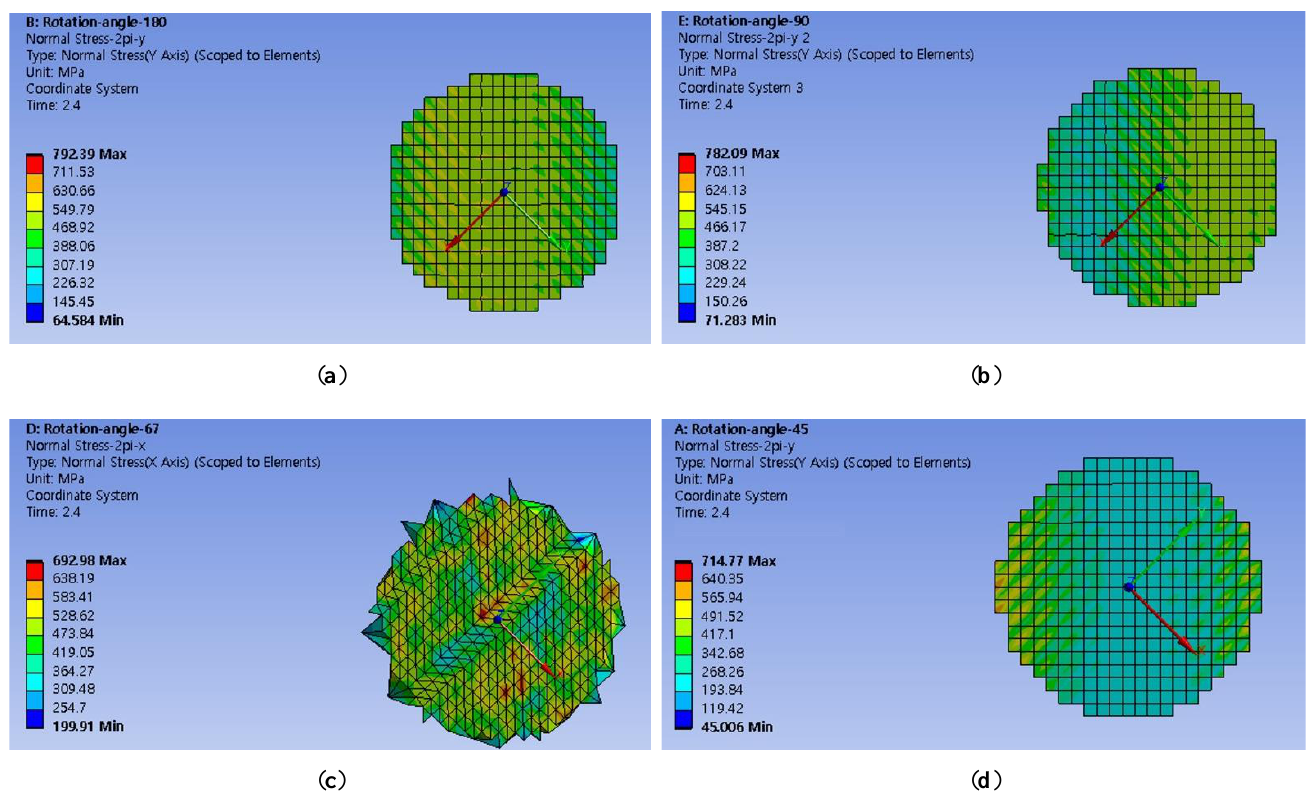
Figure 10. Residual stress results of XRD measurement area. ( a ) Rotation angle = 180°, ( b ) Rotation angle = 90°, ( c ) Rotation angle = 67°, ( d ) Rotation angle = 45°.